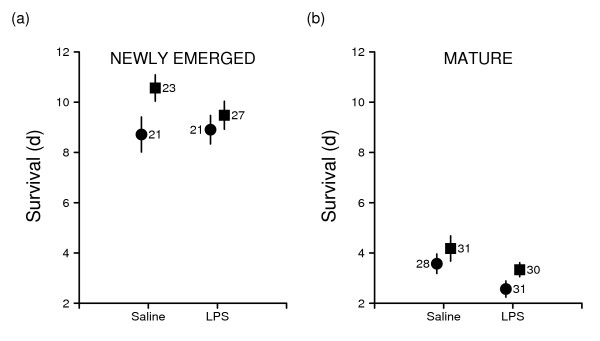
Mean days (± 1 SE) survived for males (circle) and females (square) of (a) newly emerged and (b) mature Enallagma boreale after injection of either saline or LPS and held at 15°C after an initial 24 h at 22°C to allow response to LPS. Numbers indicate sample size.